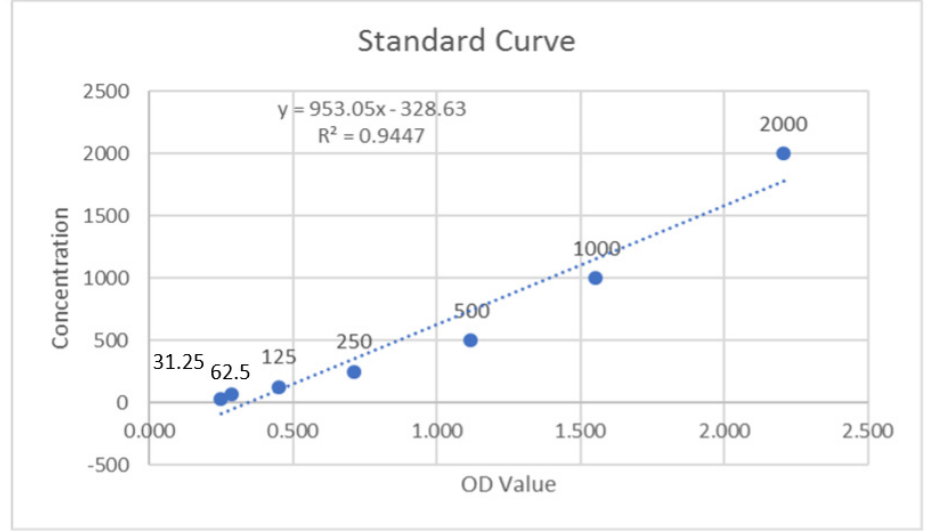
Figure 2. Standard curve of MMP-9 for test group.